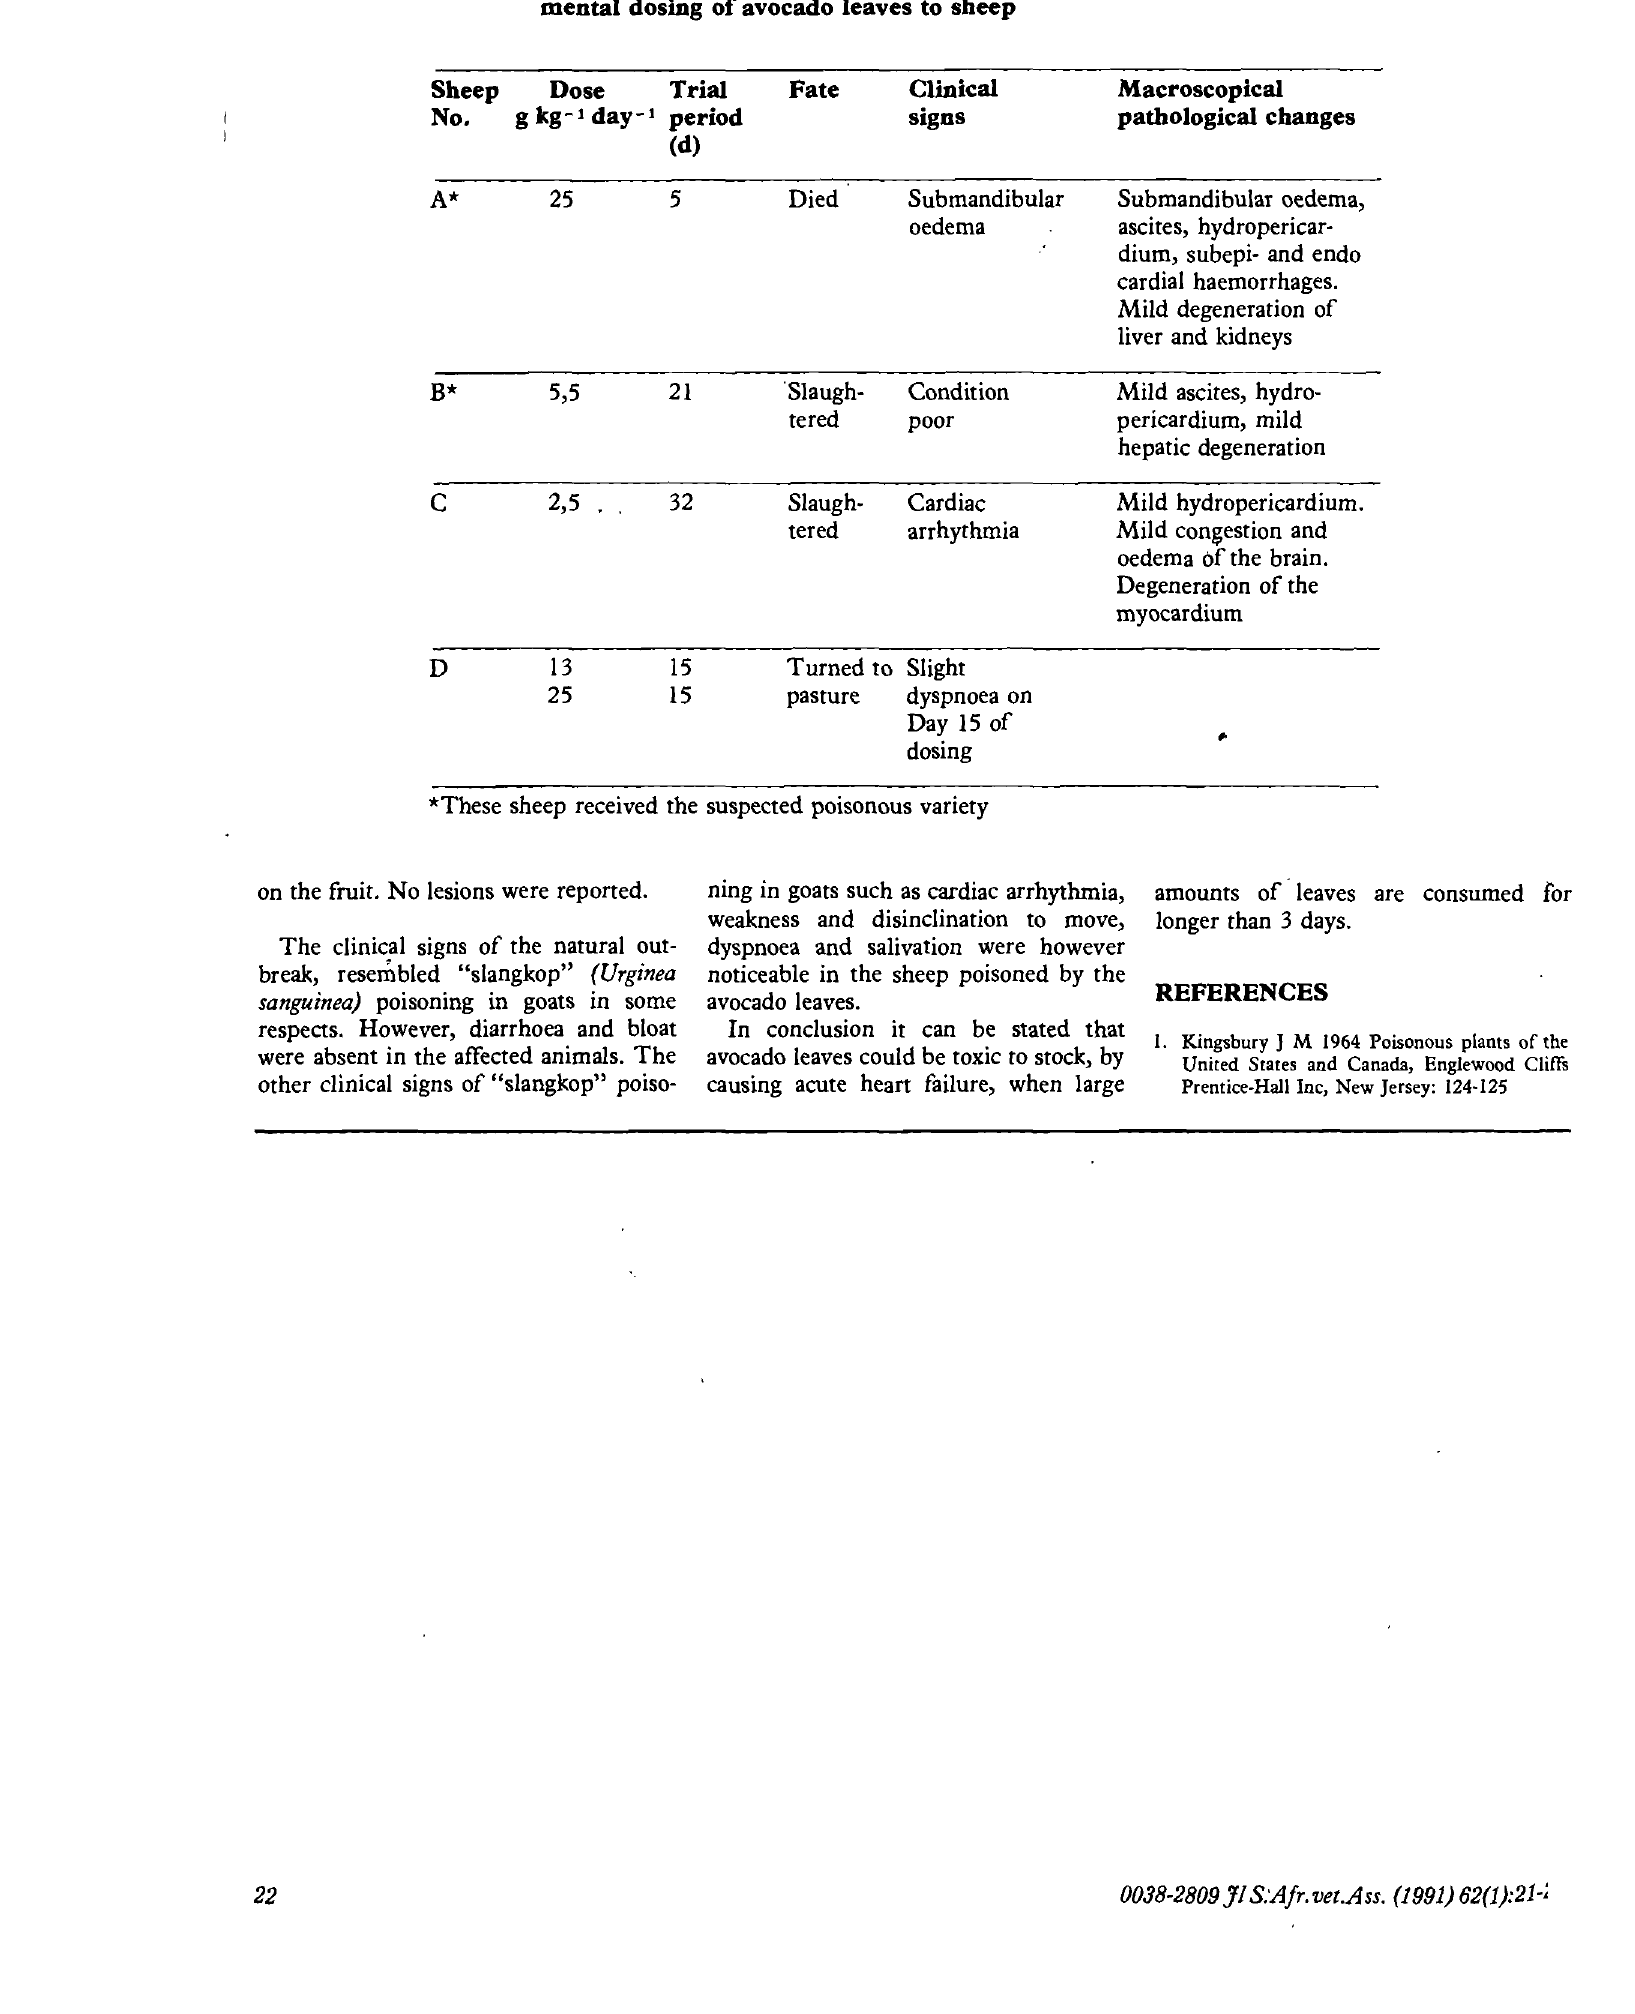
Table 1: Summary of dosage regimens and clinical signs encountered with